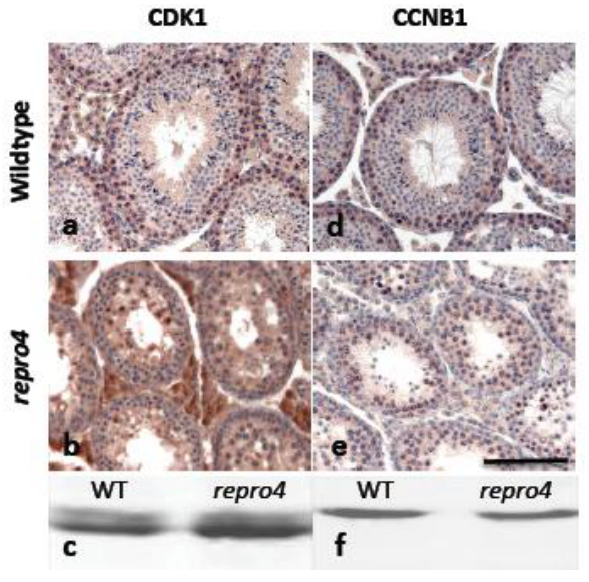
Figure 3. Protein components of MPF are present in repro4 mutant spermatocytes. Both immunohistochemistry ( a , b , d and e ) and western blotting ( c and f ) revealed that CDK1 ( a , b and c ) and CCNB1 ( d , e and f ) were present in both WT and repro4